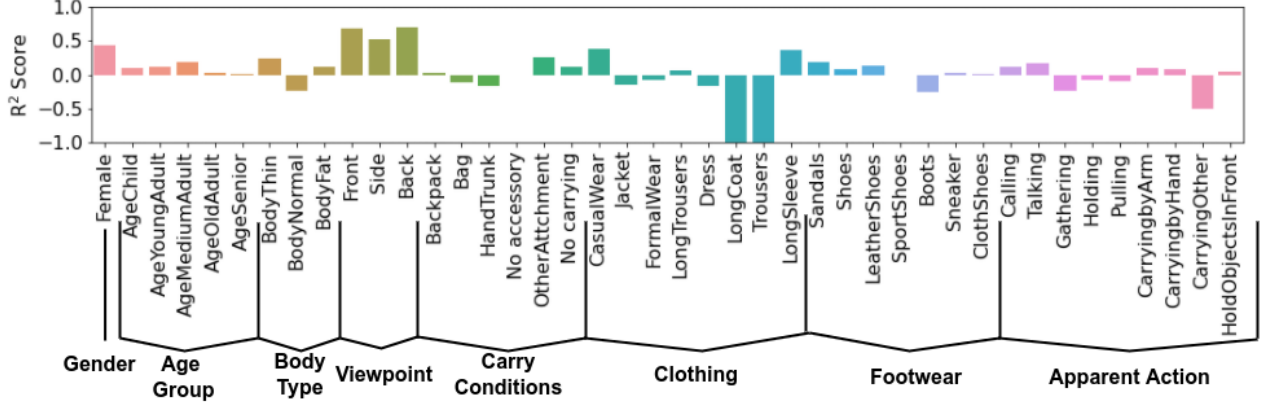
Figure 8. GaitFormerMD performance in terms of R 2 score. GaitFormerMD was trained with the multi-task objective. The model uses only movement information to predict attributes, and no information regarding the appearance of the